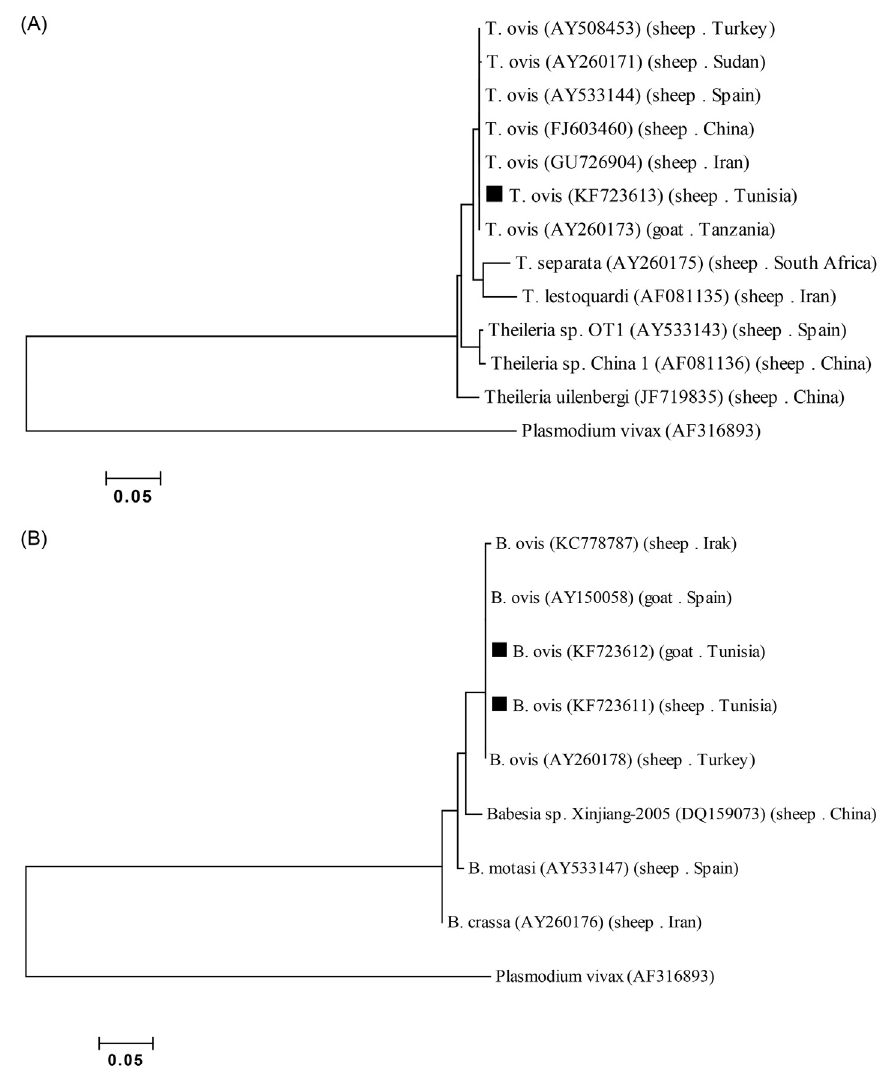
Figure 3. The tree was constructed using the neighbour-joining method [34]. The percentage of replicate trees in which the associated taxa clustered together in the bootstrap test (1100 replicates) is shown next to the branches [16]. The evolutionary distances were computed using the Tamura-Nei method [38] and are in the units of the number of base differences per site. Evolutionary analyses were conducted in MEGA5.1 [39]. GenBank accession numbers are given in parentheses. Species described in this study are indicated with a black